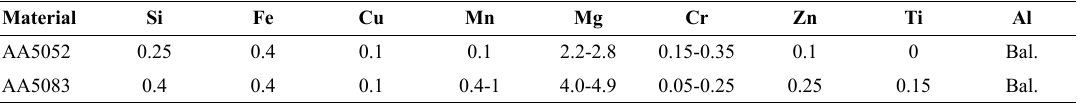
Table 1. Chemical composition of aluminum alloys 24 .